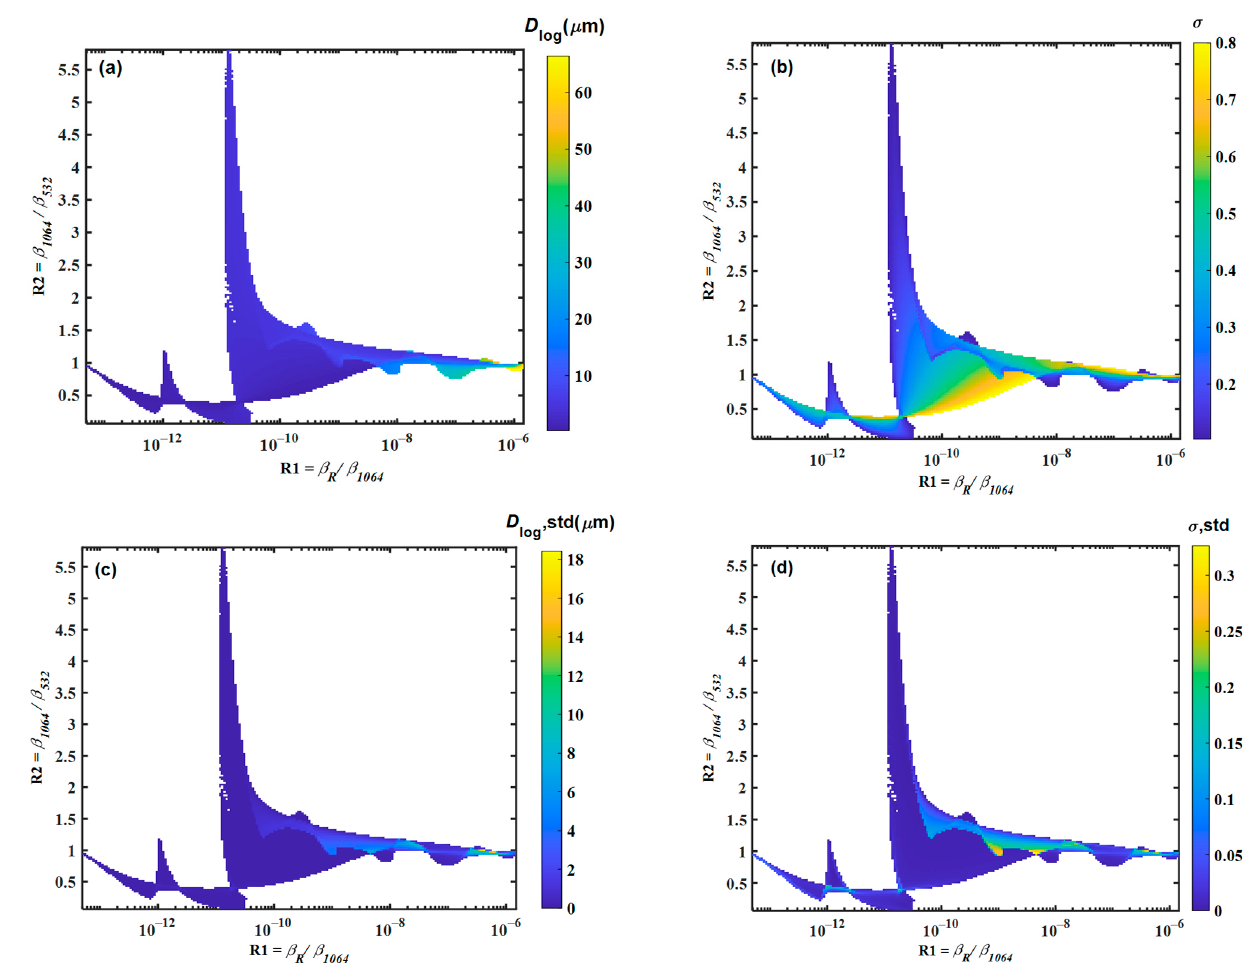
Figure 3. ( a ) The backscatter statistical model for median diameter ( D log ); ( b ) the backscatter statistical model for logarithmic width of the distribution ( σ ); ( c ) the standard deviation of the D log ( D log , std ) in the backscatter statistical model; ( d ) the standard deviation of σ ( σ , std ) in the backscatter statistical model.